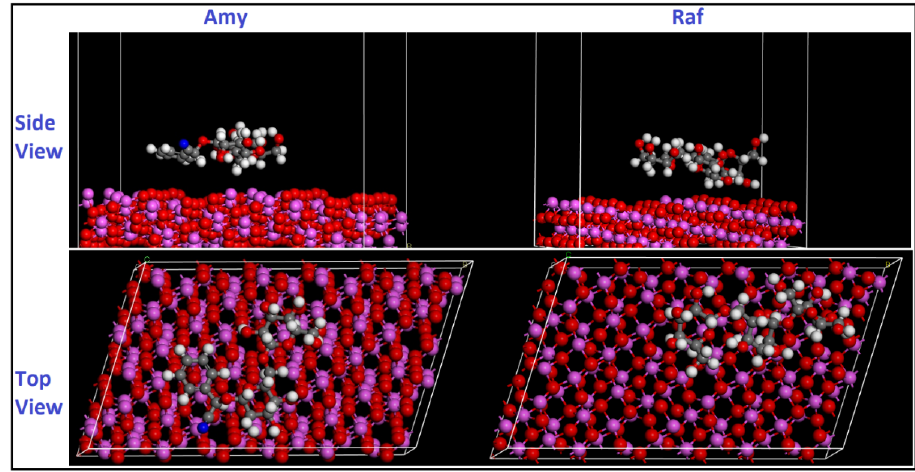
Figure 18. Side and top views of the most stable low energy configurations for the adsorption of Amy and Raf on Al (111) surface obtained using MD simulations. and Raf on Al (111) surface obtained using MD